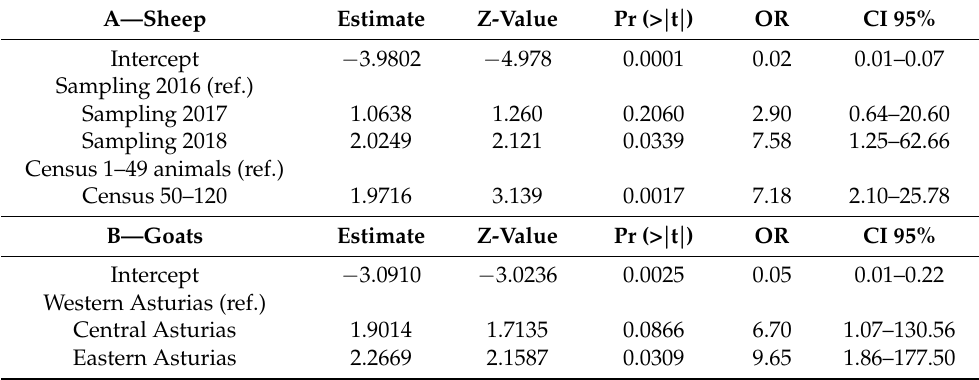
Table 2. Logistic regression models for the seroprevalence against C. burnetii in sheep (A) and goats